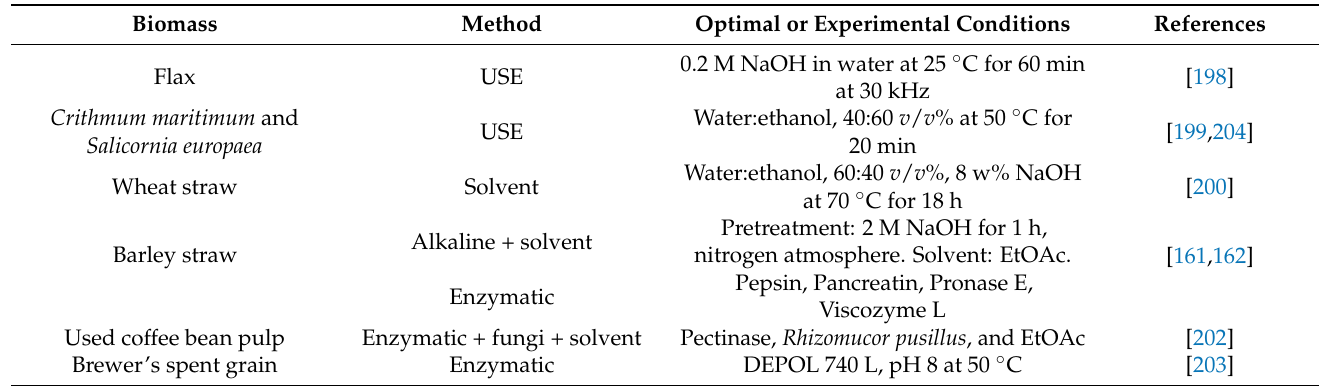
Table 15. Review of extraction methods for